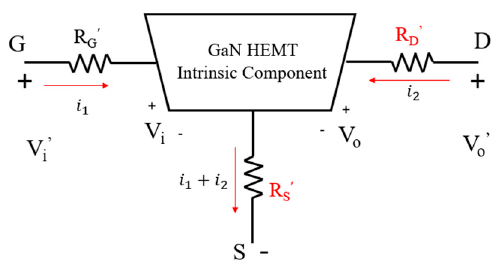
Figure 3. Small signal model of GaN HEMT.